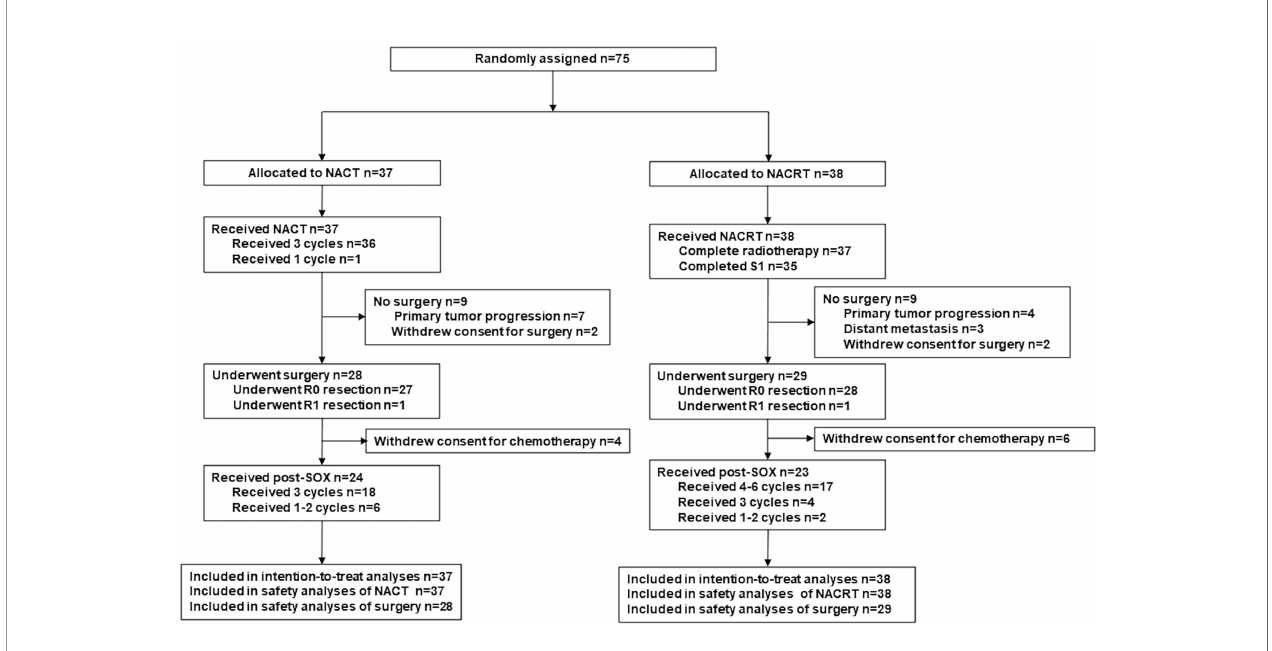
FIGURE 1 | CONSORT diagram.